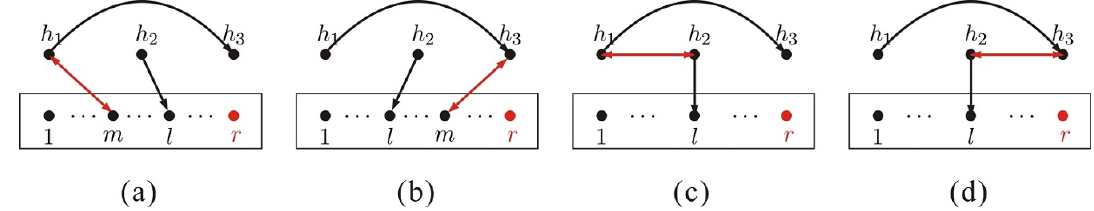
Figure 27 . All graphs F containing the skeleton F 0 = (cid:12)gure 6 (c). Relative orders of h 1 , h 2 and h 3